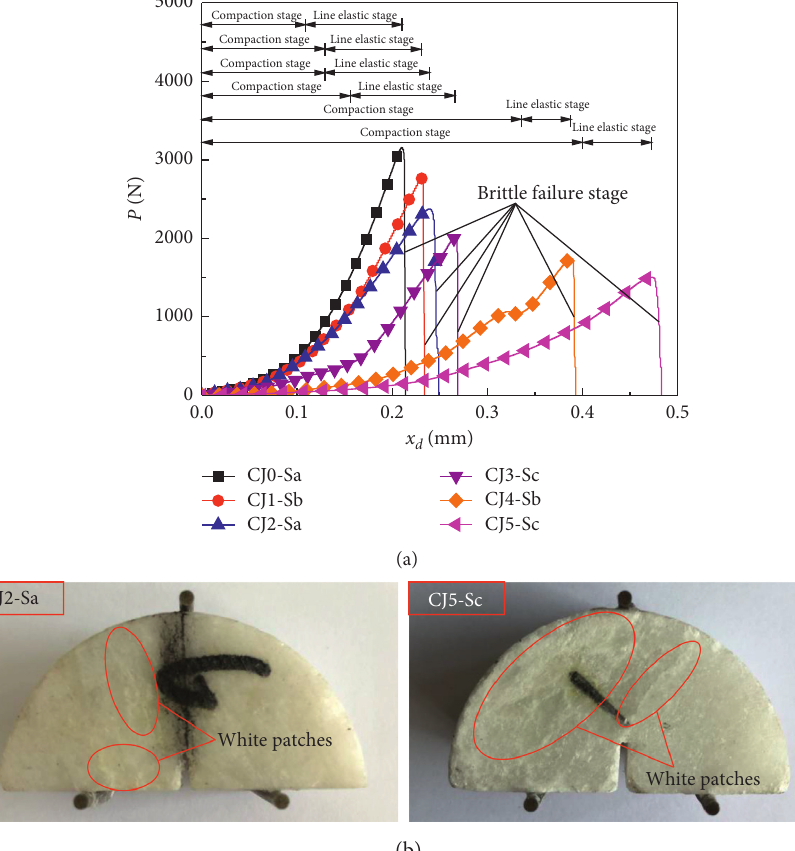
Figure 8: Load-displacement curves and impacted surfaces of the specimens. (a) The typical load-displacement curves. (b) Comparison of the impacted surfaces.